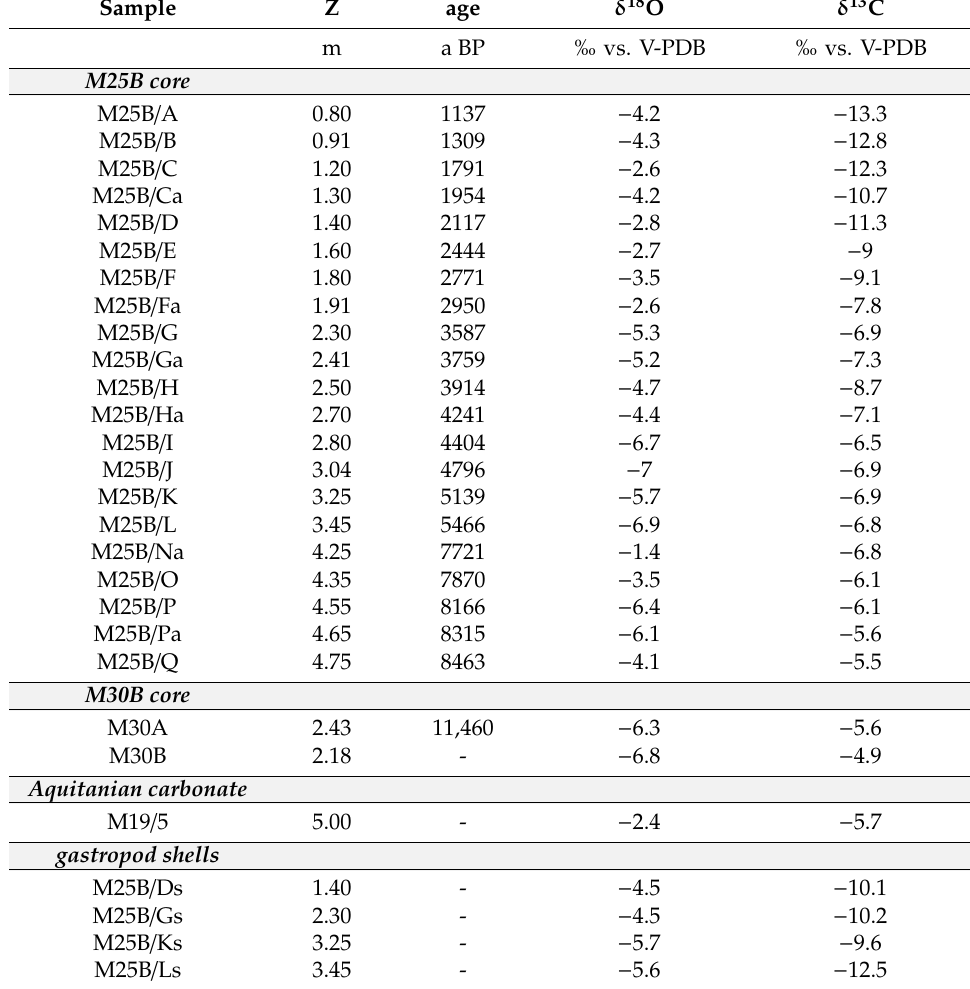
Table 2. Carbon- and oxygen-isotope compositions of the sediment in the M25B and M30 cores; Z indicates the sampling below the soil